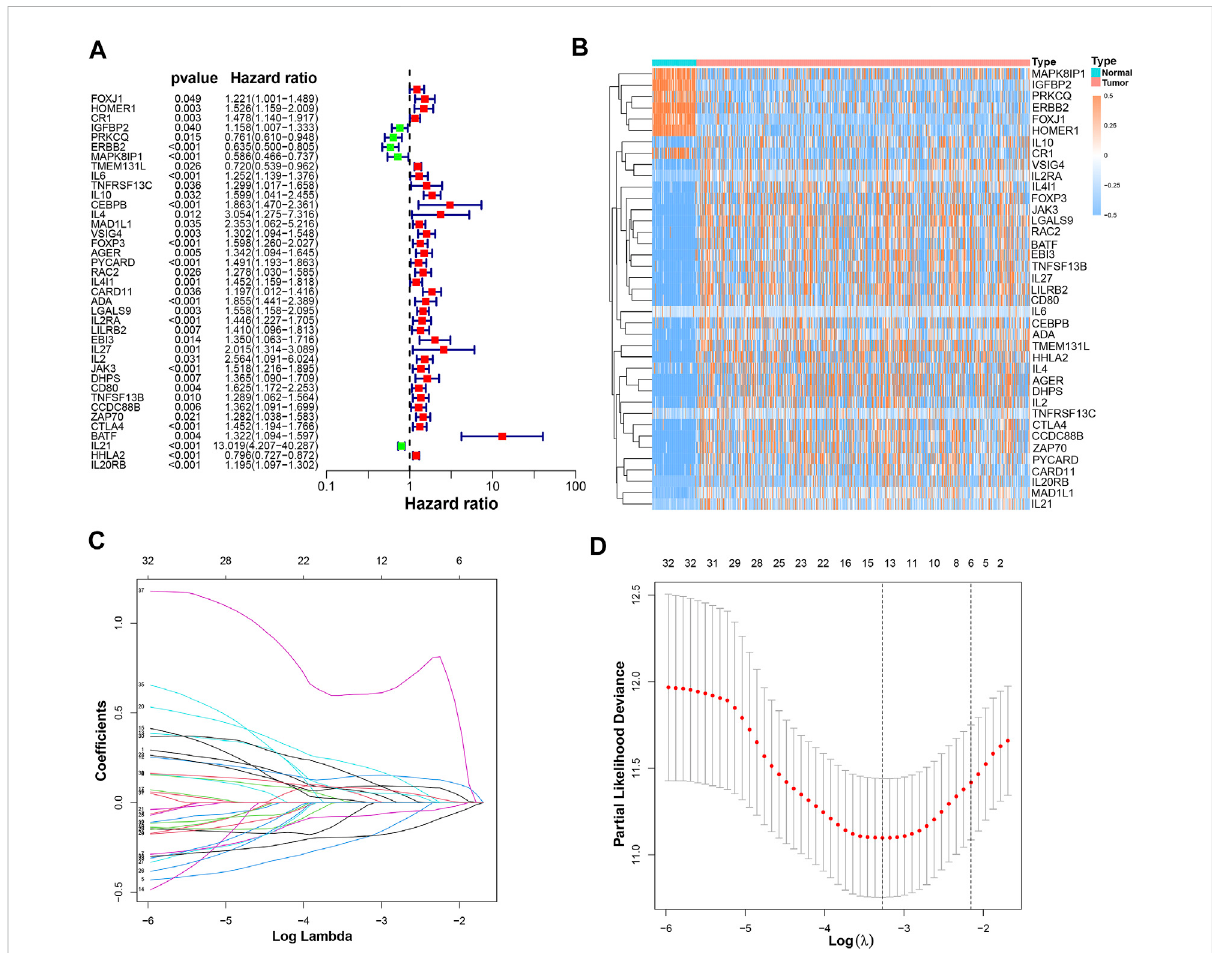
FIGURE 3 The construction of a prognostic model. (A) 39 prognostic TRGs extracted by univariate Cox regression analysis from 104 differentially expressedTRGs; (B) theheatmapofthese39prognosticTRGs; (C) theLASSOcoef fi cientpro fi lesofthese39prognosticTRGs; (D) the10-foldcross- validation for variable selection in the LASSO